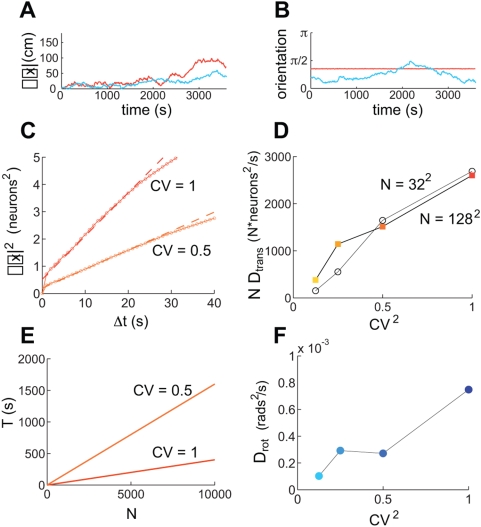
Quantification of drift induced by neural stochasticity, in the
absence of velocity inputs.Orange (blue) curves are the results of simulations in (a)periodic
networks. Successively darker shades (of orange or blue) represent
simulations with successively higher neural variability (, , , and 1, respectively). Identical colors across
panels represent simulations with identical network parameters.
Velocity inputs are zero everywhere, and network size is , except where stated otherwise. (A) Phase drift
and (B) angular drift of the periodic (orange,
CV = 1) and aperiodic (blue, ) networks. In (A), the drift in cm corresponds to
a measured drift in neurons by assuming the same gain factor as in
the simulations with a trajectory, as in Figure 5. (C) The summed square
2-d drift in position estimation as a function of elapsed time, for
two different values of CV, in the absence of velocity inputs. The
squared drift (small open circles) can be fit to straight lines
(dashed) over 25 seconds (for longer times the traces deviate from
the linear fit due to the finite time of the simulation), indicating
that the process is diffusive. The slope of the line yields the
diffusion constant  for phase (translational) drift of the population
pattern, in units of neurons 2/s. The same fitting
procedure applied to the squared angular drift as a function of time
yields the angular diffusion constant . (D) Diffusion constants measured as in (C), for
networks of varying size and CV. The diffusion constant is
approximately linear in CV2, and in the number of neurons . To demonstrate the linearity in , the plots show  multiplied by , upon which the data for  and  approximately collapse onto a single curve. (E) An
estimate of the time over which a periodic spiking network (with the
same parameters as the corresponding points in (C) and (D)) can
maintain a coherent grid cell response, plotted as a function of N,
for two values of neural stochasticity. The estimate is based on
taking the diffusion relationship , and solving for the time when the average
displacement  is 10 pixels, about half the population period,
and estimating the diffusion constants from (D) to be
ND≃2500 neurons2/s. The
coherence time scales like , where  is the period of the population pattern. (F)
Rotational diffusivity, , in an aperiodic network of size 128×128
also increases linearly with CV2. The diffusion constant
was measured from simulations lasting 20 minutes.